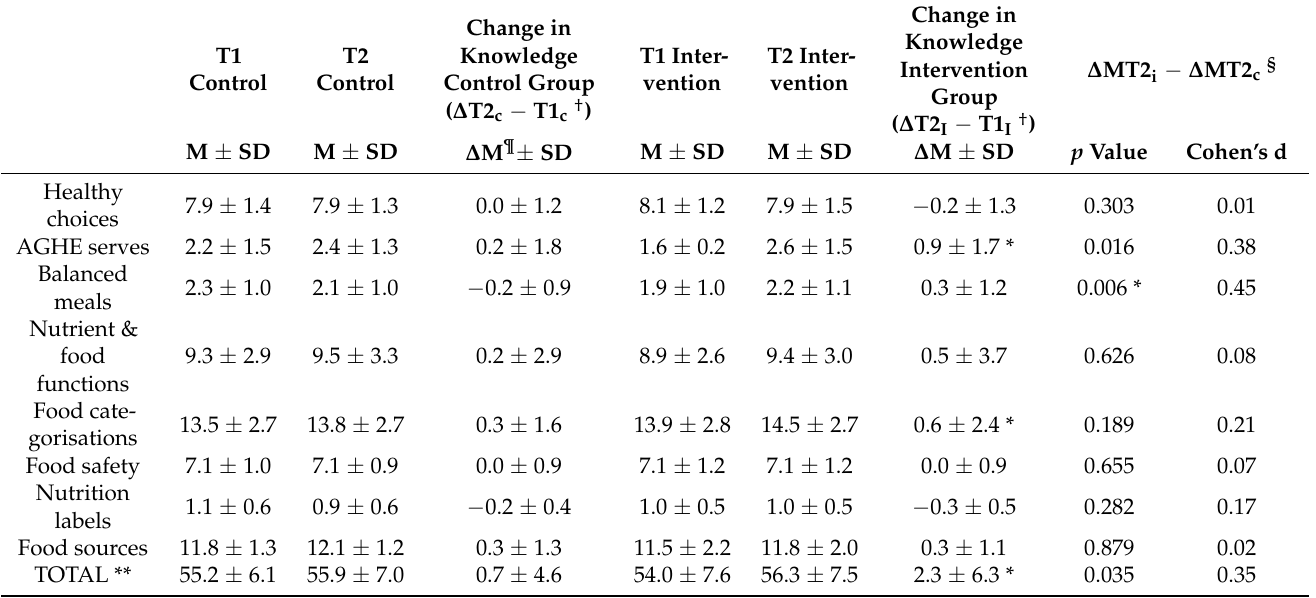
Table 3. Child Nutrition Knowledge Australian Questionnaire (CNK-AU)